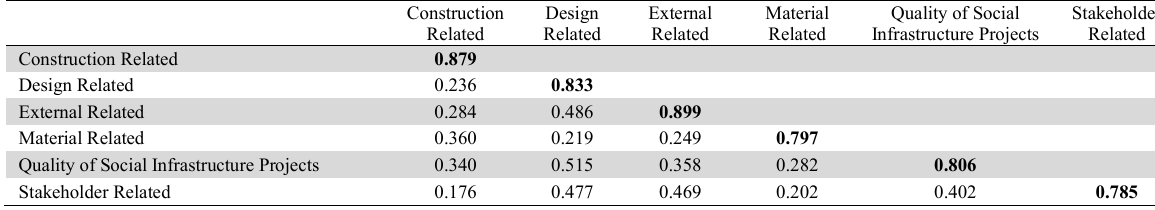
Discriminant Validity (Fornell-Larcker Criterion)